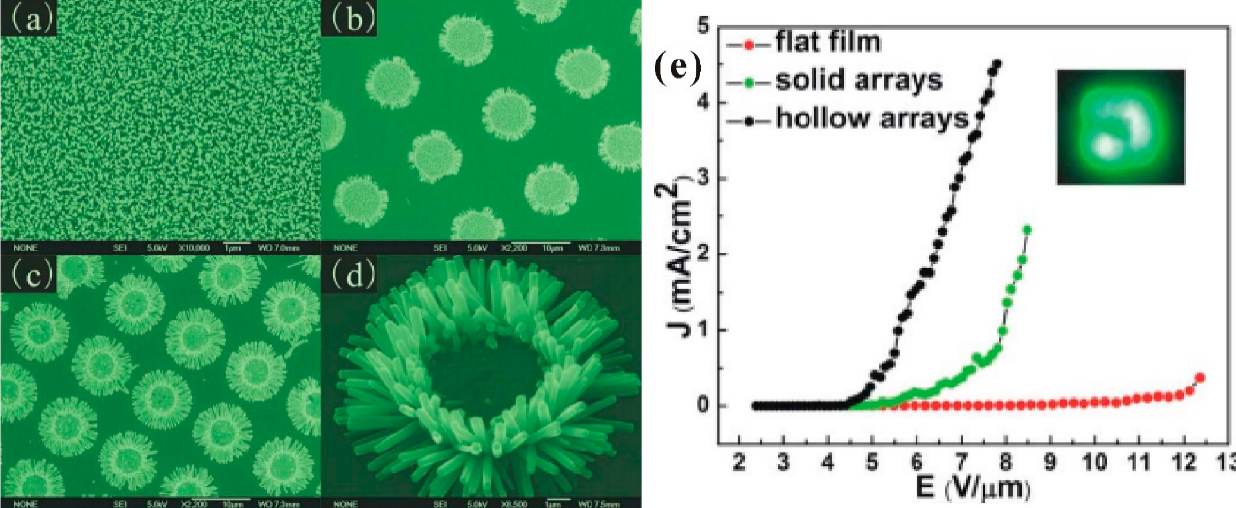
Figure 21. SEM images of ZnO nanorod with ( a ) flat film, ( b ) solid arrays and ( c ) hollow arrays. ( d ) The enlarged image of a single pattern in ( c ). ( e ) Field-emission properties of ZnO nanorod with different pattern structures. Reproduced from [90], with the permission of AIP Publishing, 2009.